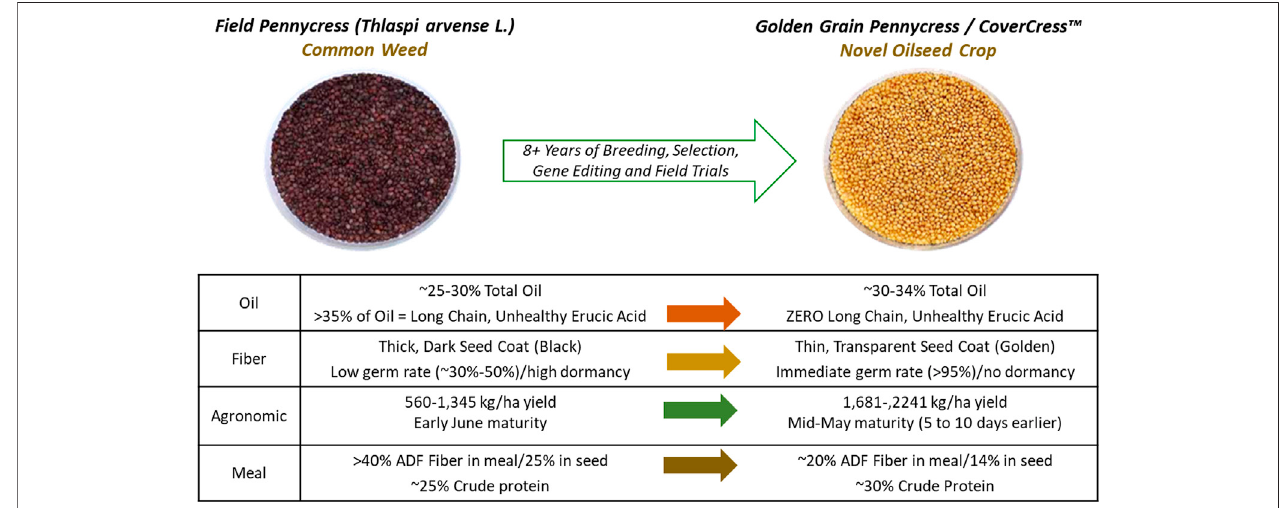
FIGURE 1 | Breeding efforts to improve pennycress to address seed yield and new markets.